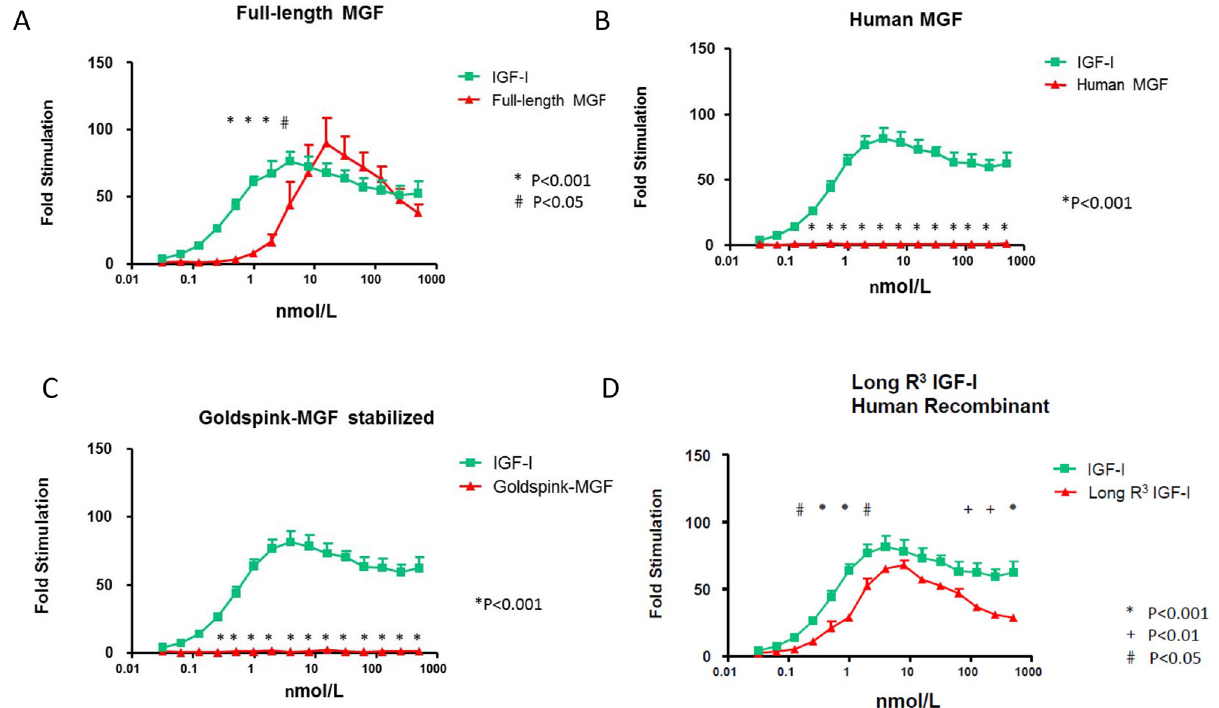
Fig 2. Stimulatory activity of the insulin-like growth factor-I receptor (IGF-IR). A : Comparison of full-length MGF (red points and line) and insulin-like growth factor-I (IGF-I) (green points and line). B: Comparison of Human MGF (red points and line) and insulin-like growth factor-I (IGF-I) (green points and line). C: Comparison of Goldspink-MGF (red points and line) and insulin-like growth factor-I (IGF-I) (green points and line). D: Comparison of Long R 3 IGF (red points and line) and insulin-like growth factor-I (IGF-I) (green points and line). Dose-response curves ranged from 0.0625 to 1000 nmol/L. For bioactivity measurements means ± SEM and signal-to-noise ratios are presented. A-C: Each point represents the mean value ± SEM of at least three independent experiments. D: Each point represents the mean value ± SEM of at least two independent experiments. P = P-value when comparing overall differences in fold stimulation between two ligands.